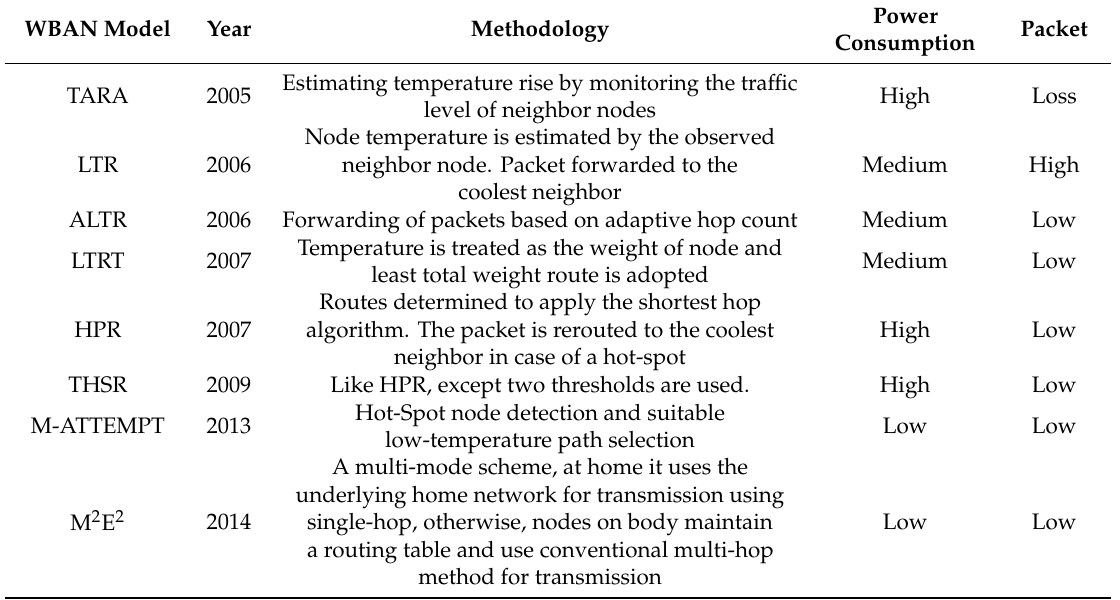
Table 1. Related